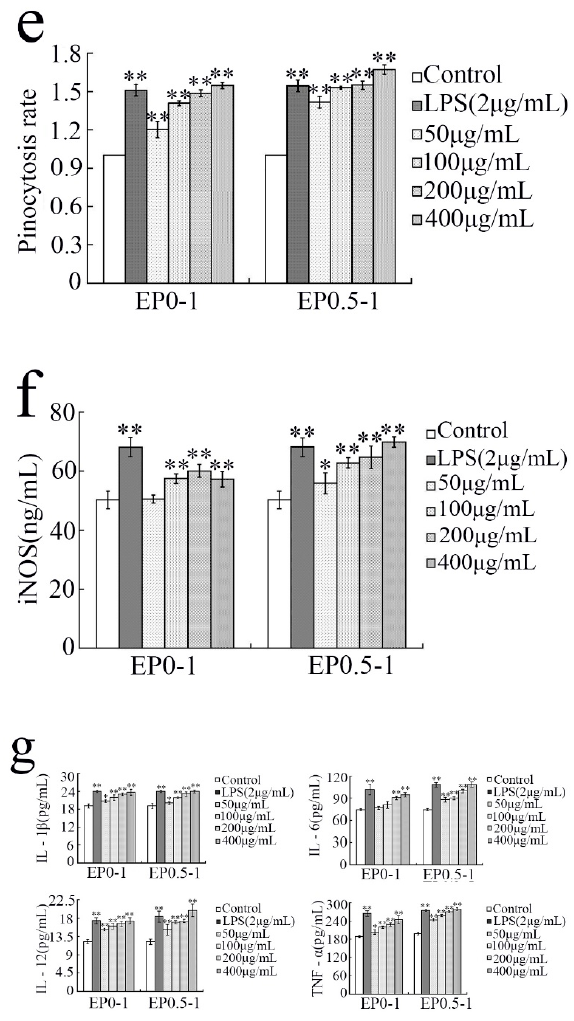
Figure 4. Immunomodulatory activity of EP0-1 and EP0.5-1 in RAW264.7 macrophages. ( a ) Effects of EP0-1 and EP0.5-1 on RAW 264.7 cell proliferation. ( b ) Effect of EP0-1 and EP0.5-1on ROS fluorescence. ( c ) ROS production. ( d ) RAW264.7 cells phagocytosed endocytic fluorescent-red latex beads (red fluorescence). ( e ) Phagocytotic activity of RAW 264.7 cells stimulated by EP0-1 and EP0.5-1. ( f ) The effect of EP0-1 and EP0.5-1 with different concentrations and LPS on the levels of iNOS in RAW264.7. ( g ) The effect of EP0-1 and EP0.5-1 with different concentrations and LPS on the levels of IL-1 β , IL-6, IL-12 and TNF- α in RAW264.7. The results were expressed as means ± SD ( n = 3). * P < 0.05, ** P < 0.01 vs. control group.